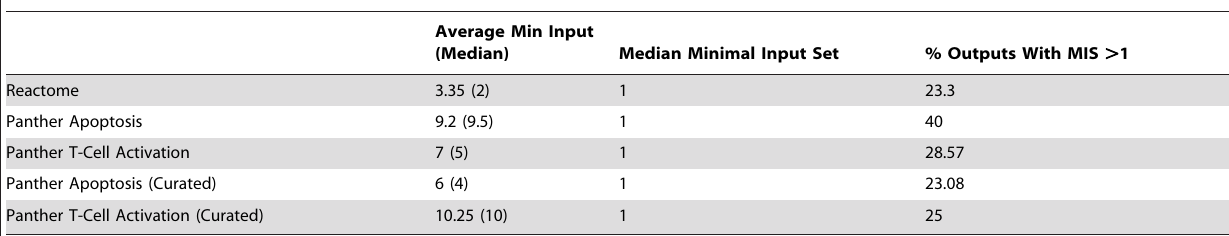
Table 1. Comparison of Signalling Data.